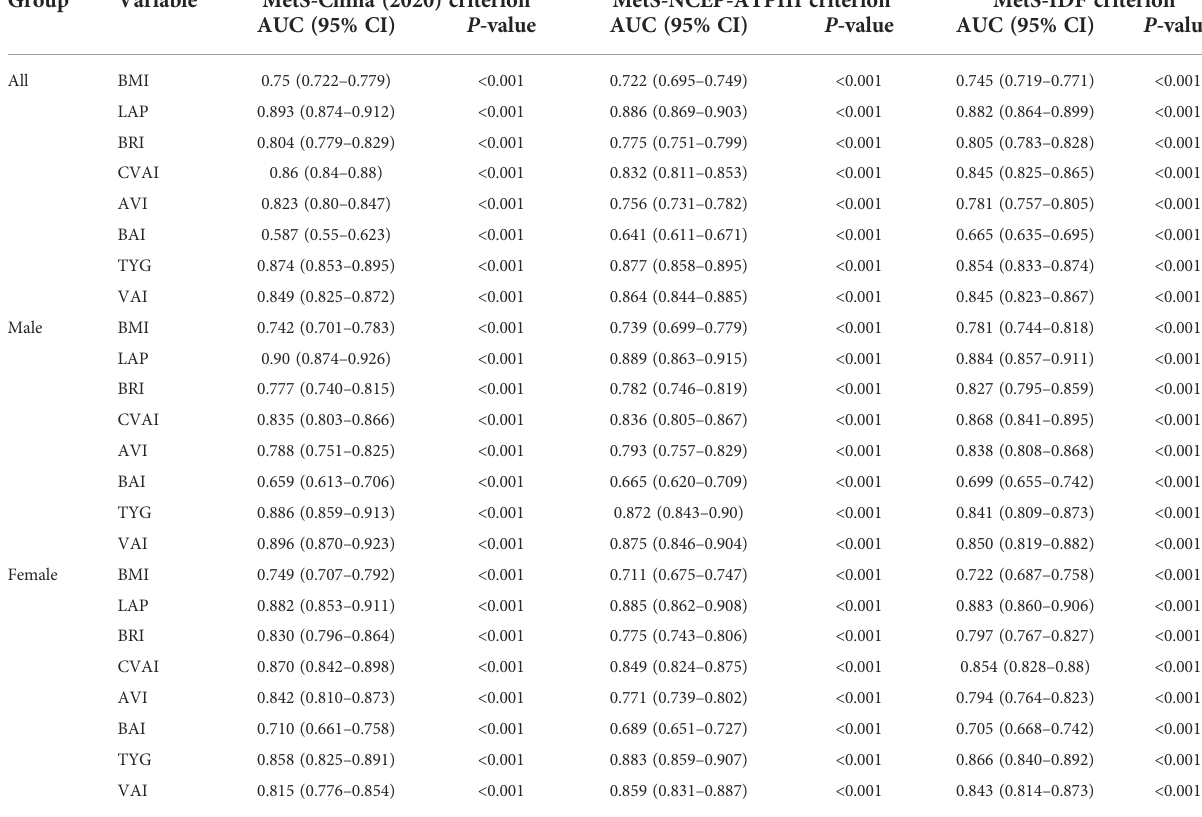
TABLE 5 Area under the curve of seven obesity- and lipid-related indices with the different metabolic syndrome